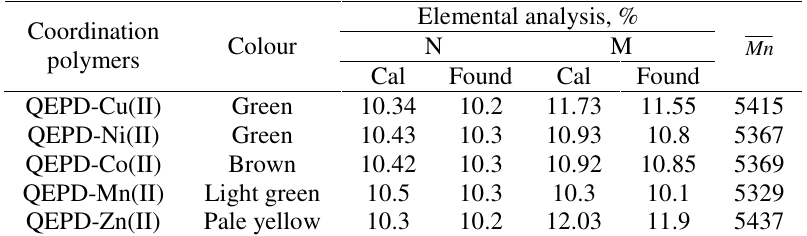
Table 1. Analytical data for coordination polymer of QEPD.